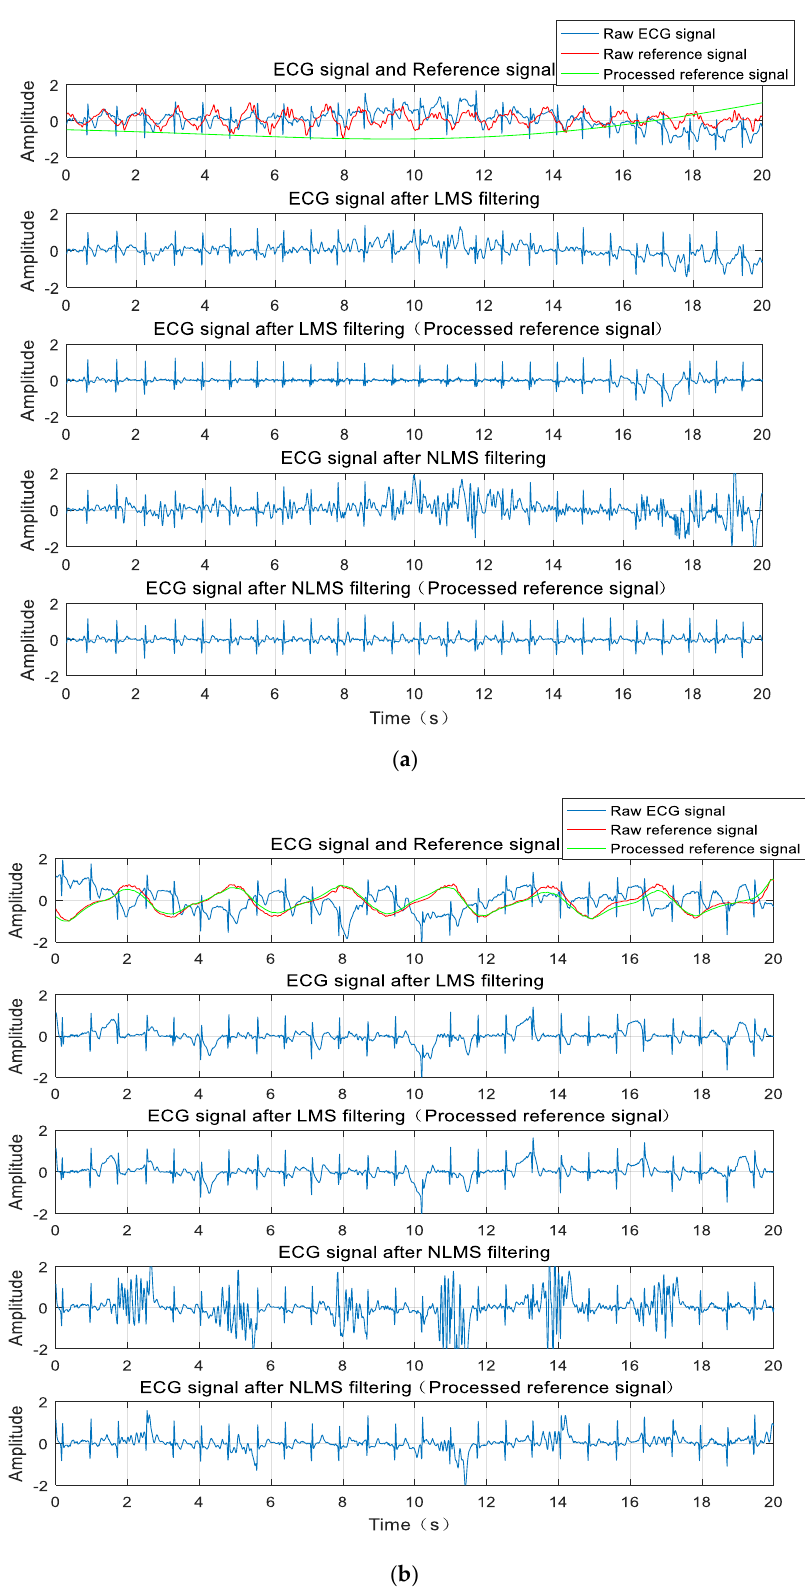
Figure 7. ECG signal before filtering, the reference signal, and the filtered ECG signal waveforms for ( a ) walking and ( b ) bending. ( a ) walking and ( b )